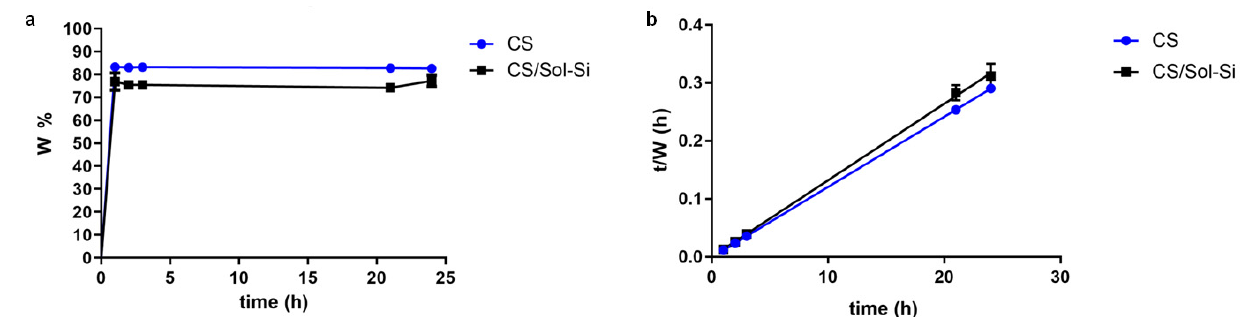
Figure 3. ( a ) Percentage of swelling of CS and CS/Sol-Si over a period of 24 h in PBS buffer. ( b ) CS and CS/Sol-Si experimental data for water content and time plotted according to a second-order kinetic model. Data were obtained from triplicate results and are shown as mean ± SD. Table 2. CS and CS/Sol-Si biocomposite water content at equilibrium (W ∞ ) and coefficient of determination (r 2 ) of water content and time plotted according to second-order kinetics.